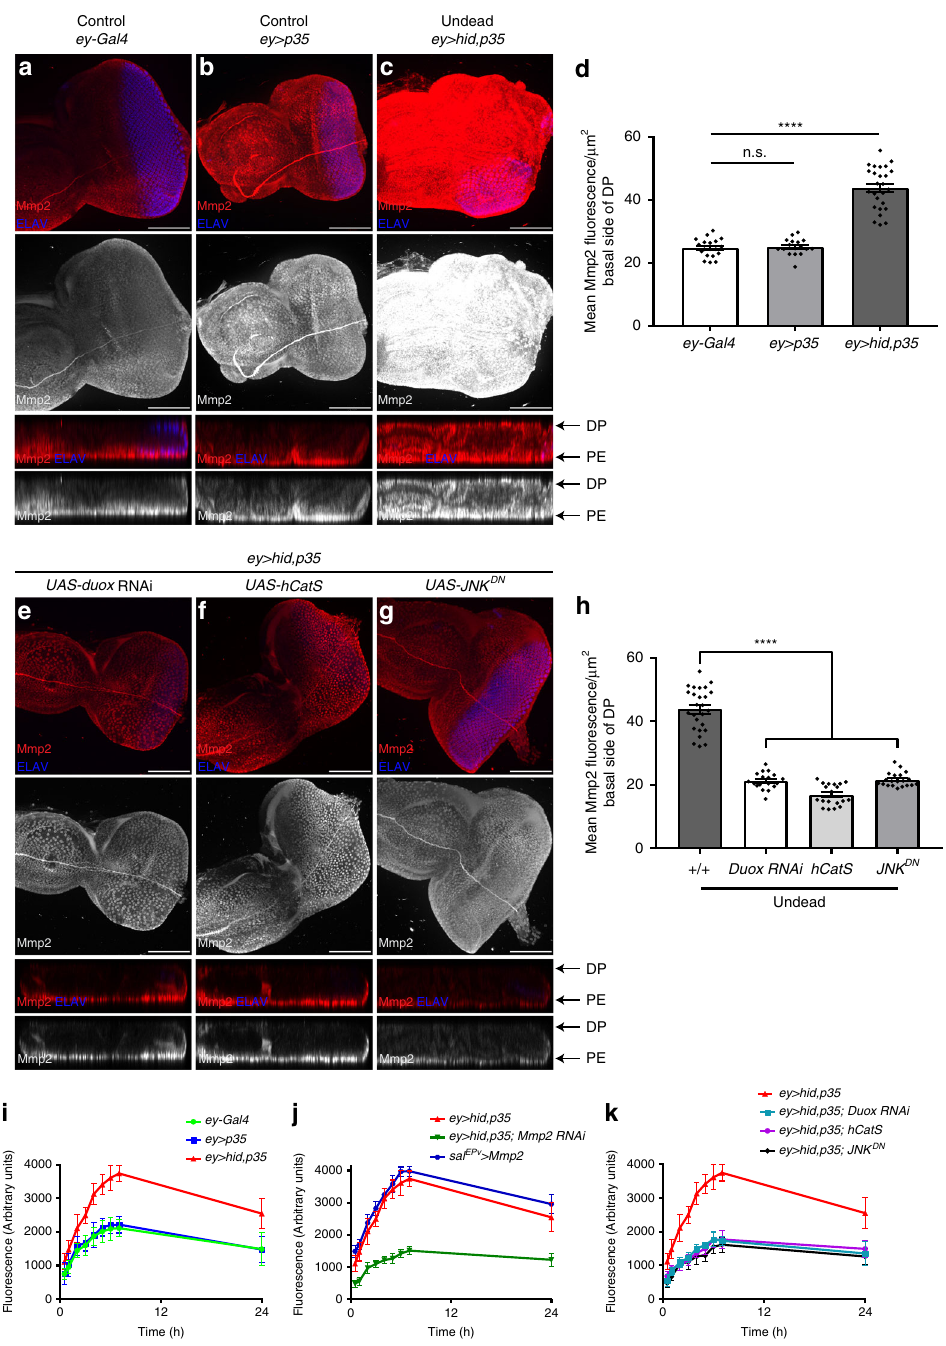
Fig. 4 Upregulation of Mmp2 levels and activity in undead discs requires ROS and JNK. a – c Representative examples of control ( ey-Gal4 ( a ) and ey > p35 ( b )) and undead ( ey > hid,p35 ( c )) eye imaginal discs labeled for Mmp2 (red and gray) and ELAV (blue). Orthogonal (YZ) section views (bottom panels) show increased localization of Mmp2 at the basal side of the DP in undead ey > hid,p35 discs compared with controls. Scale bars, 100 μ m. d Quanti fi cation of Mmp2 intensity in a – c taken from single slices at the basal surface of DP, represented as mean fl uorescence ± SEM analyzed by one-way ANOVA with Holm – Sidak test for multiple comparisons. **** p < 0.0001, n.s. = no statistical signi fi cance. Data from n = 19 ( ey-Gal4 ), 17 ( ey > p35 ), and 26 ( ey > hid,p35 ) discs analyzed from four independent experiments. Quanti fi cation of Mmp2 intensity at the PE shown in Supplementary Fig. 9b. e – g Examples of ey > hid, p35 eye imaginal discs expressing Duox RNAi ( e ), transgenic hCatS ( f ), and dominant negative JNK ( JNK DN ) ( g ) labeled for Mmp2 (red and gray) and ELAV (blue). Orthogonal (YZ) cross section views (bottom) show suppression of the Mmp2 upregulation at the basal side of the DP compared with undead discs. Scale bars, 100 μ m. h Quanti fi cation of Mmp2 intensity in e – g taken from single slices at the basal surface of DP, represented as mean fl uorescence ± SEM analyzed by one-way ANOVA with Holm – Sidak test for multiple comparisons. **** p < 0.0001, n.s. = no statistical signi fi cance. Data from n = 26 ( ey > hid,p35 ), 18 ( duox RNAi), 19 ( hCatS ), and 20 ( JNK DN ) discs analyzed in three independent experiments. i – k Mmp2 activity measured by fl uorometric assay using DQ-gelatin cleavage substrate, represented as mean ± SEM from three independent experiments. The same ey > hid,35 data (red lines) are shown in i – k . This increased fl uorescence in ey > hid,35 discs is lost upon knockdown of Mmp2 , and is comparable to Mmp2 overexpression ( j ). Mmp2 activity in ey > hid,p35 undead discs is dependent on ROS and JNK ( k ). Source data are provided as a Source Data fi